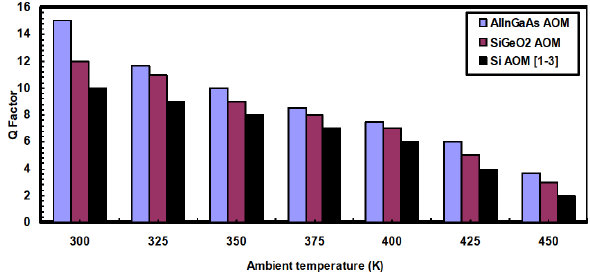
Figure 8: Variations in Q Factor in relation to ambient temperature for the previous and proposed